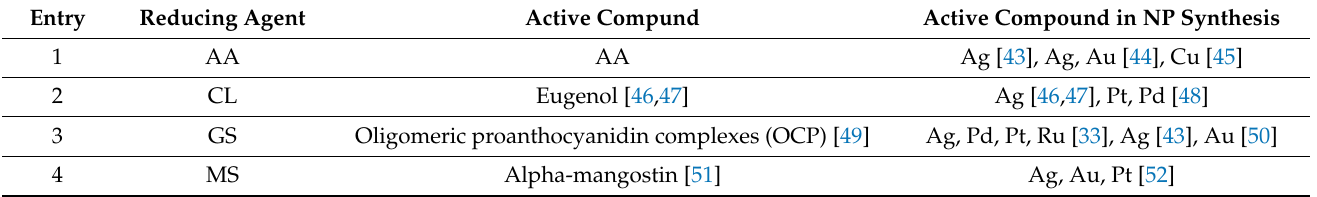
Table 4. Overview of active compounds in reducing agents and literature examples for application of active compounds in NP